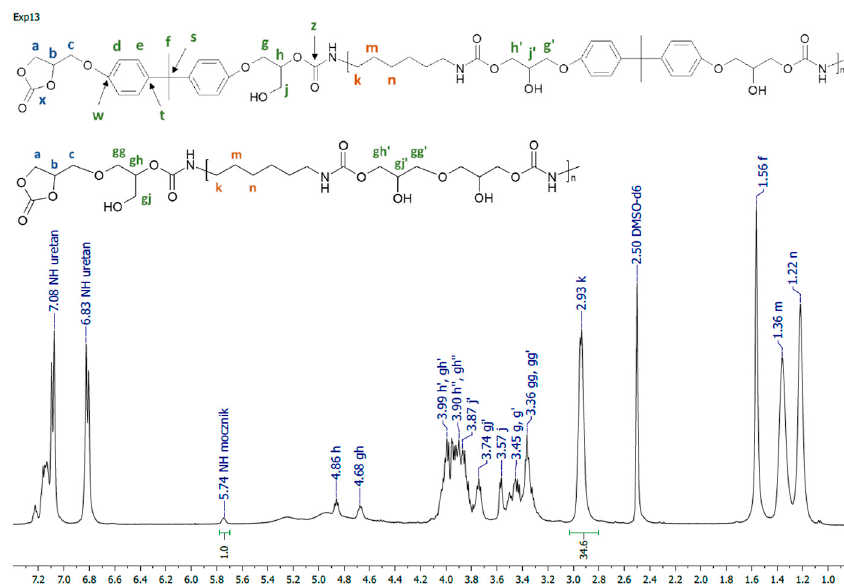
Figure 3. 1H NMR spectrum of PHU synthesized in experiment run nos. 1–4,13–15.